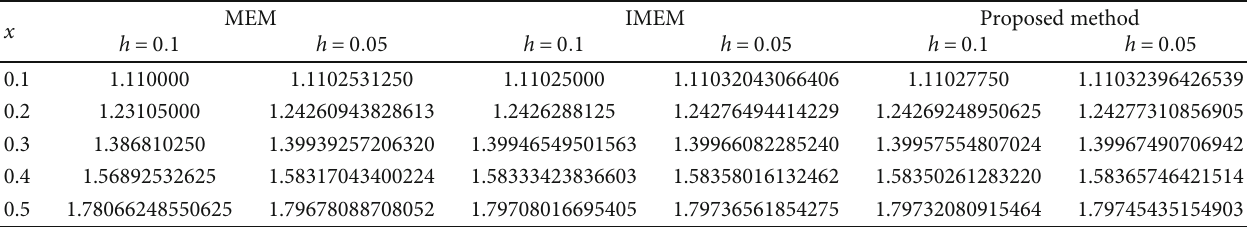
Table 3: Numerical solutions for Example 2.